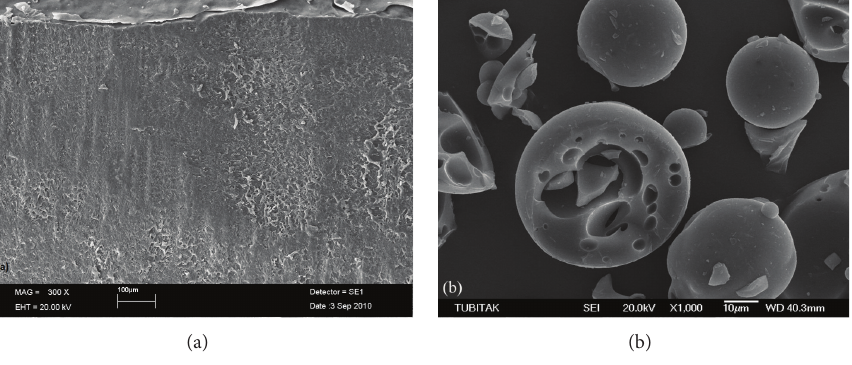
Figure 3: SEM image; (a) PMMA (b) lignin.